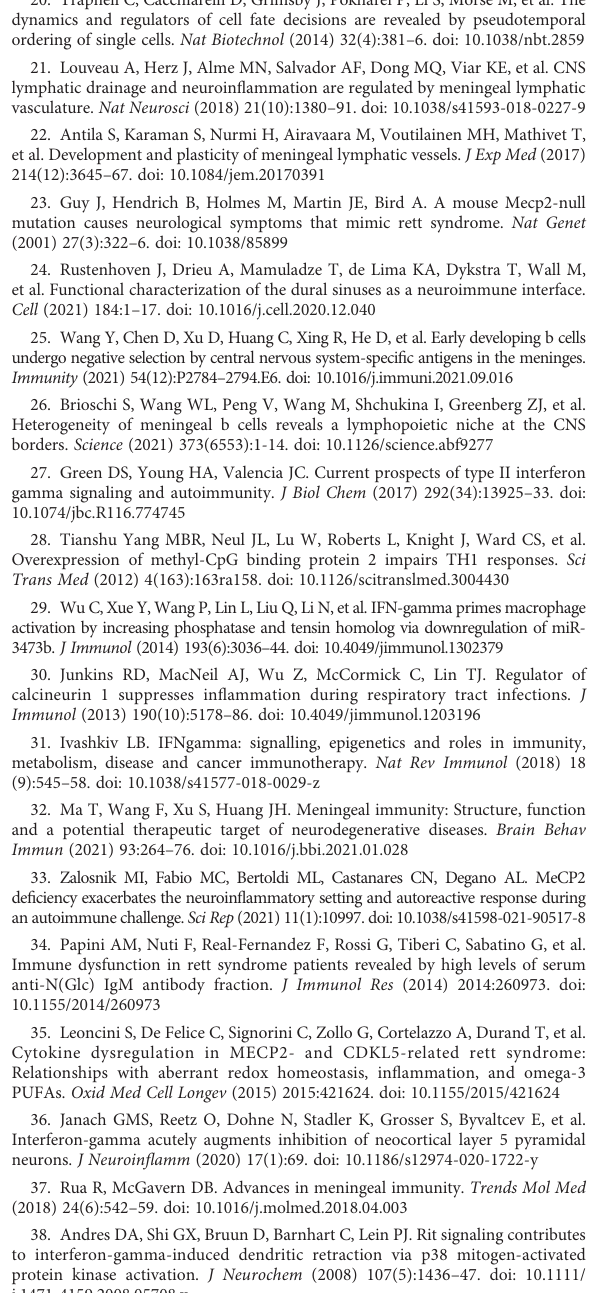
SUPPLEMENTARY FIGURE 1 Single-cell characterization of meningeal immune cells with typical signature marker genes. (A) Umap plot displays distributions of 18 major clusters of meningeal immune cells. (B) Log2 expression of Ptprc in individual cells on the Umap graph of (A) . (C) Violin plots showing the expression of signature genes for different immune cell types.